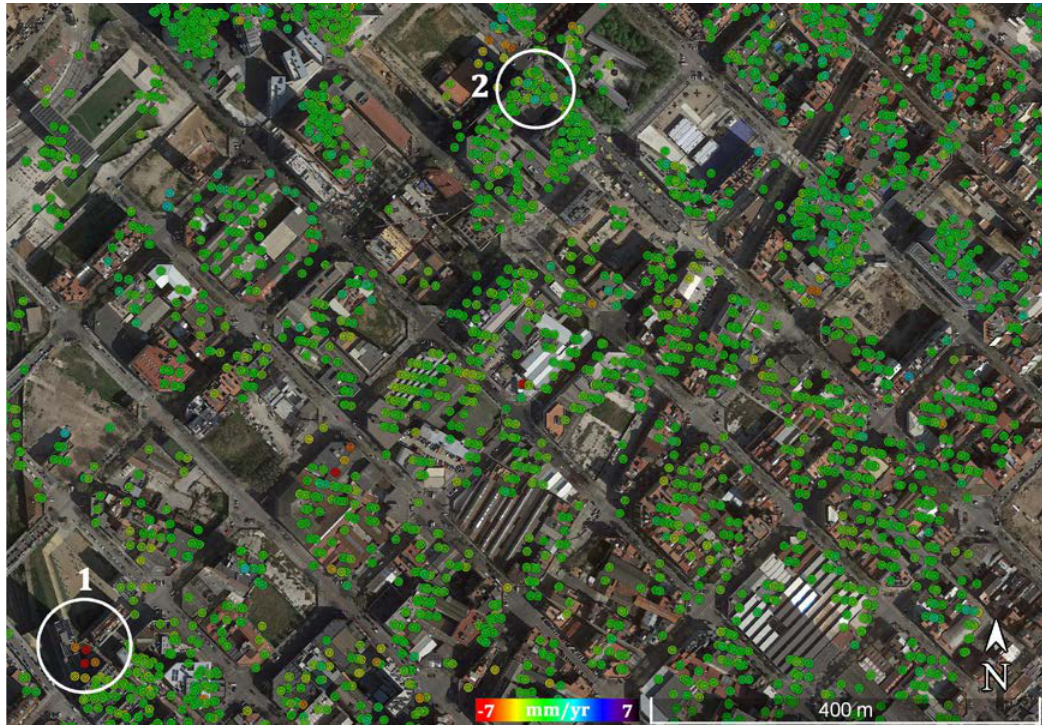
Figure 2. Deformation velocity map over a portion of the area of interest.